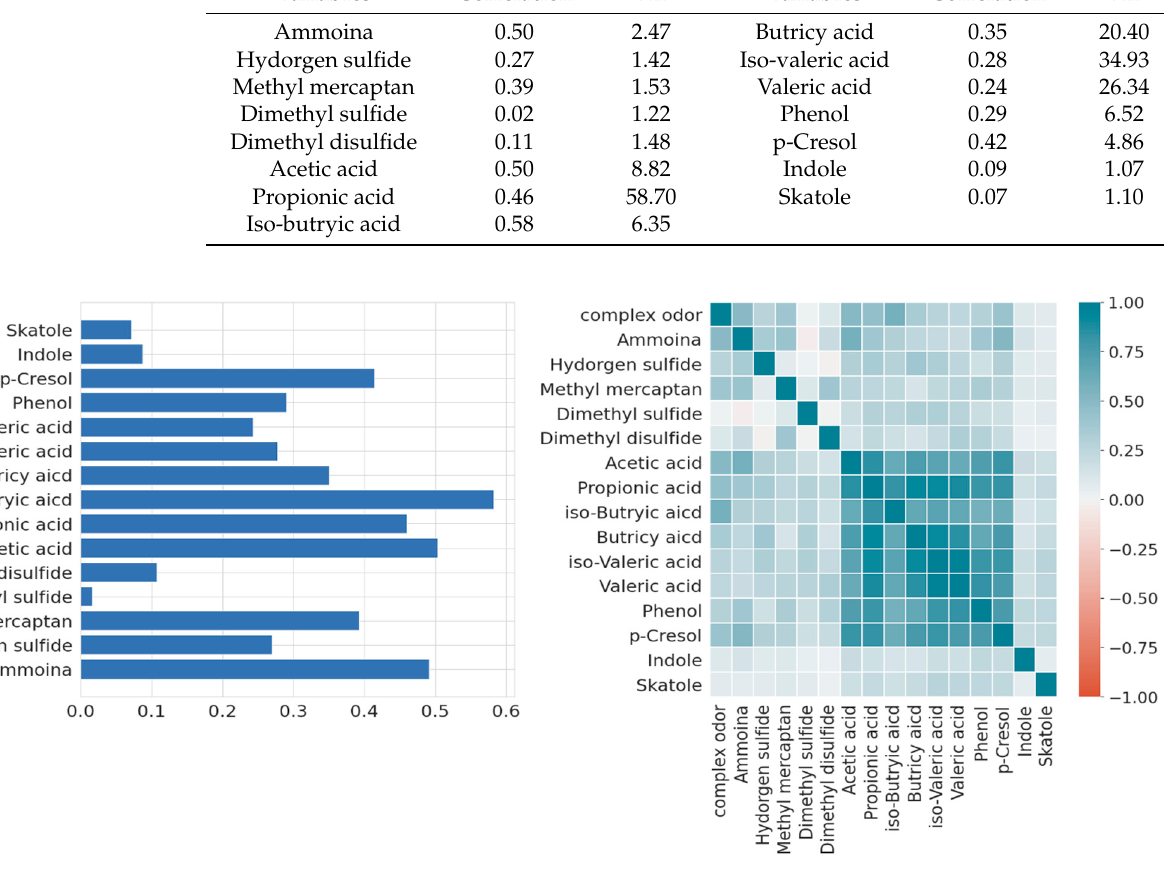
Figure 5. Number of counts for location and season. An ANOVA was performed to determine whether the average amount of occurrence differed for each categorical variable generated in this way, and whether the generated categorical variable was meaningful as a variable. As shown in Table 6, the subscripts (A, B, and C) above the numbers grouped the mean of each category in the case of variables with significant differences in mean. For example, in the case of hydrogen sulfide, it can be said that there is no difference between the categories In and Out because the averages